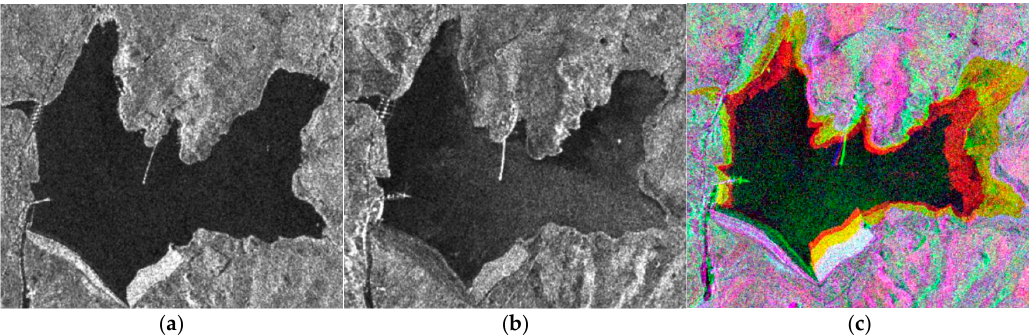
Figure 4. Smooth and rough water surfaces (left and central panels, respectively) sensed by CSK on the 23 June and 15 February 2012, and diachronic CSK false-color composition for increasing H m , (281.10, 285.31 and 291.40 m represented in red, gran and blue color scales, respectively). Table 2. CSK acquisition parameters.